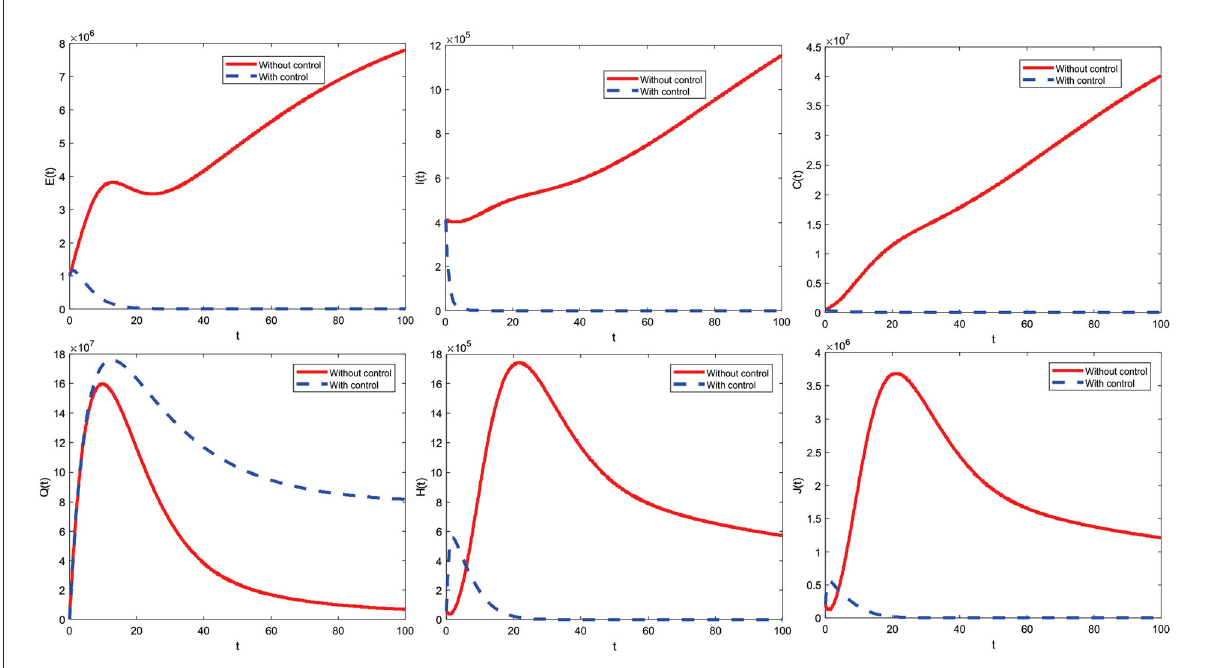
FIGURE9 The optimal control simulation results with u 2 6= 0.